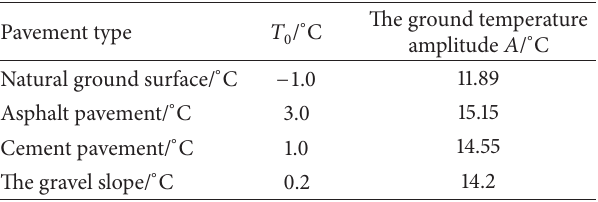
Table 6: The annual ground temperature and the ground tempera- ture amplitude in the top boundaries.